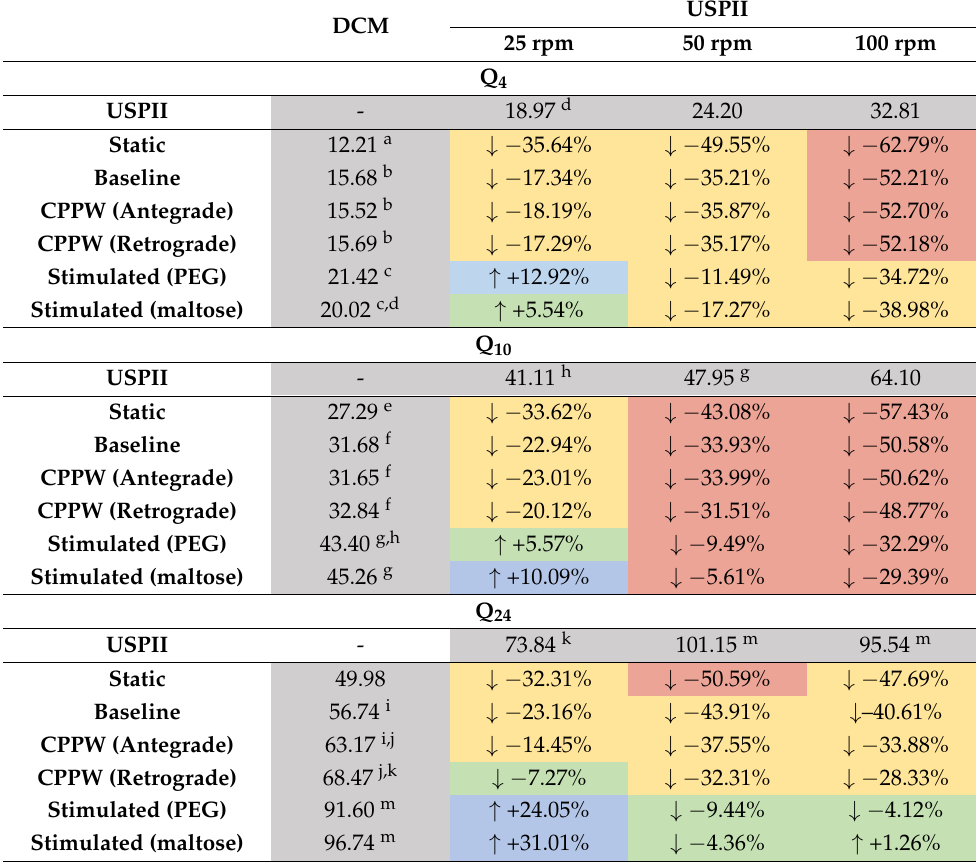
Table 5. Release (Q) comparison at t = 4, 10 and 24 h in the DCM using different motility patterns and the USPII at 25, 50 and 100 rpm, presented in the grey boxes. Comparison is colour-coded wherein red indicates > 50% discrepancy between the DCM and the USPII, blue and yellow indicate 10–50% positive and negative difference, respectively and green shows results that lie within 10% of one another. The arrow indicates the positive and negative difference wherein a ‘up’ arrow ( ↑ ) shows a positive difference where release in the DCM was higher than the USPII, and vice versa. Statistical similarities where p > 0.05 are indicated at each timepoint by values that share the same superscript letter.